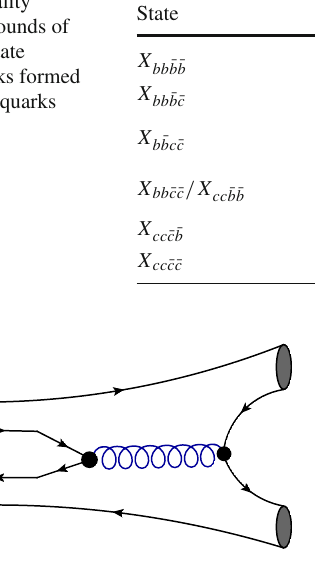
Fig. 2 Quark level description of hadronic decays X where M 1 and ¯ M 2 are spin-parity and phase-space allowed bottom and anti-bottom meson,